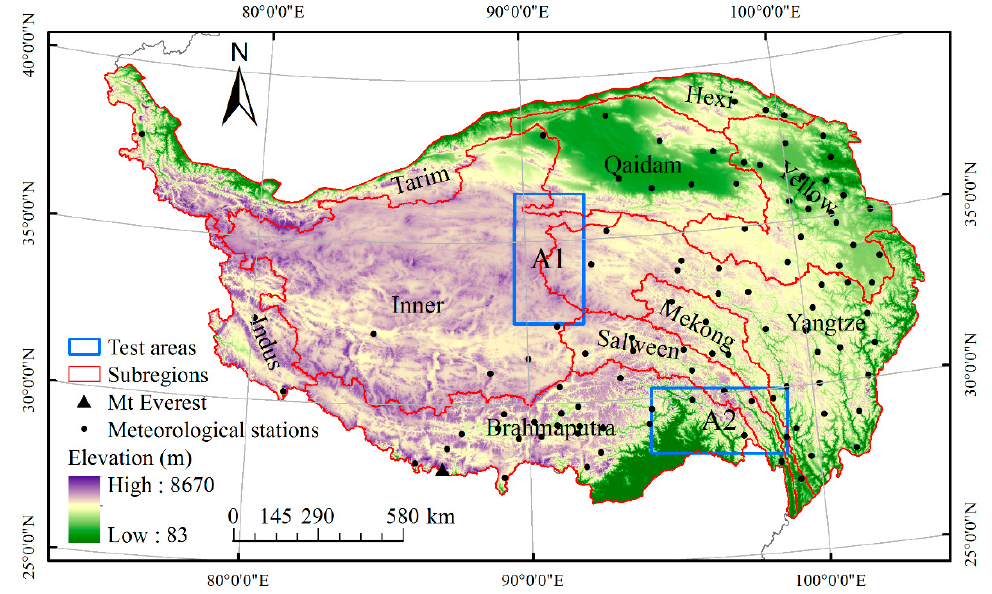
Figure 1. Topographic relief (https://earthexplorer.usgs.gov/), meteorological stations, subregions, and test areas for the parameter determination over the Tibetan Plateau (TP).